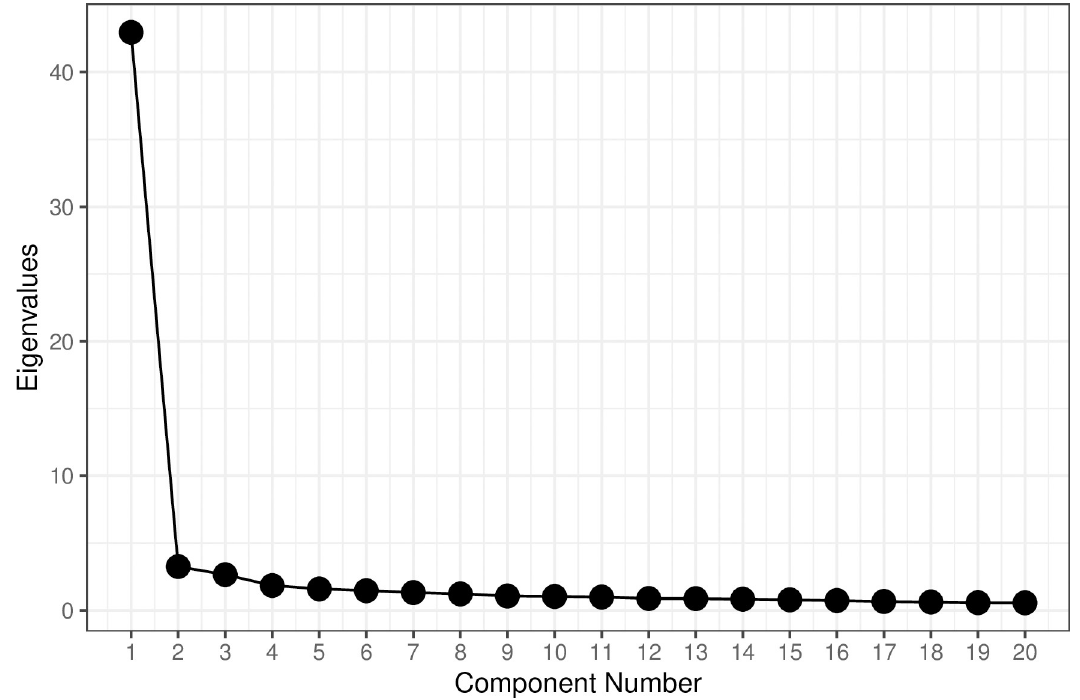
Fig 1. Scree plot of the eigenvalues (Pilot Study). Note: The number of components shown here was limited to 20. The real maximum number of components was 75.